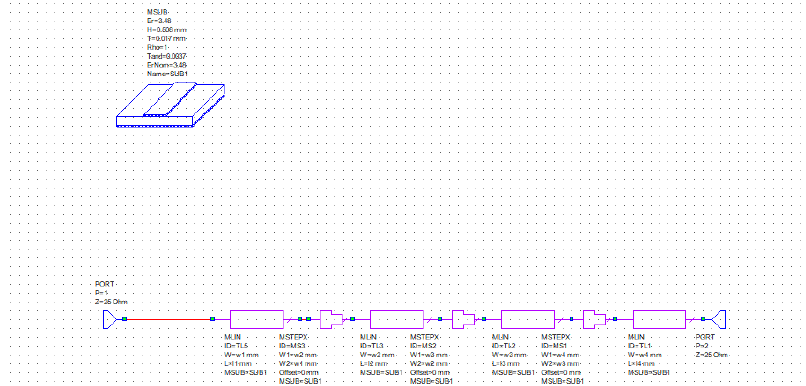
Fig. 5. Electrical circuit of output matching the amplifier stage.